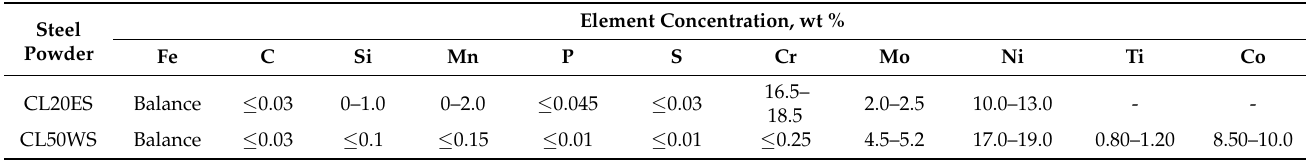
Table 1. Chemical composition of the metal powders (material data Concept Laser GmbH).